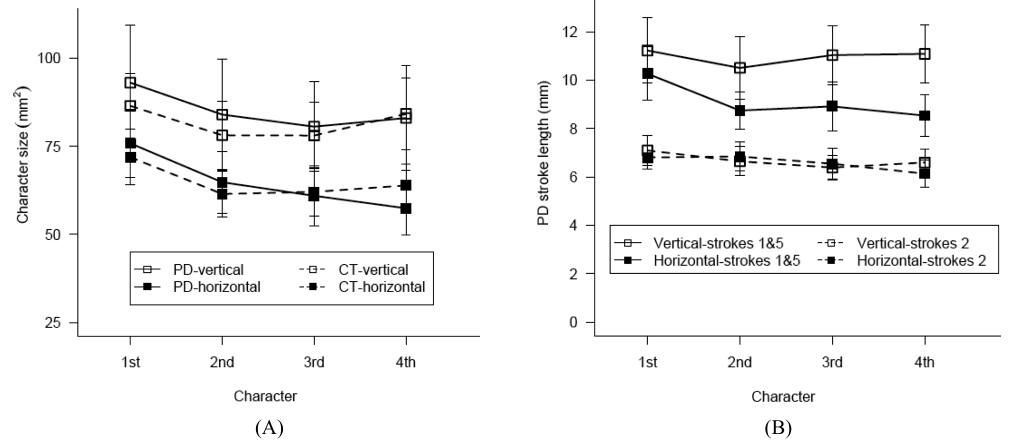
Fig. 2. (A) Character size (mean ± standard error) of Parkinson’s disease and control groups in the horizontal and vertical directions. (B) Stroke length (mean ± standard error) of the PD group in the horizontal and vertical directions. CT = controls; PD = Parkinson’s